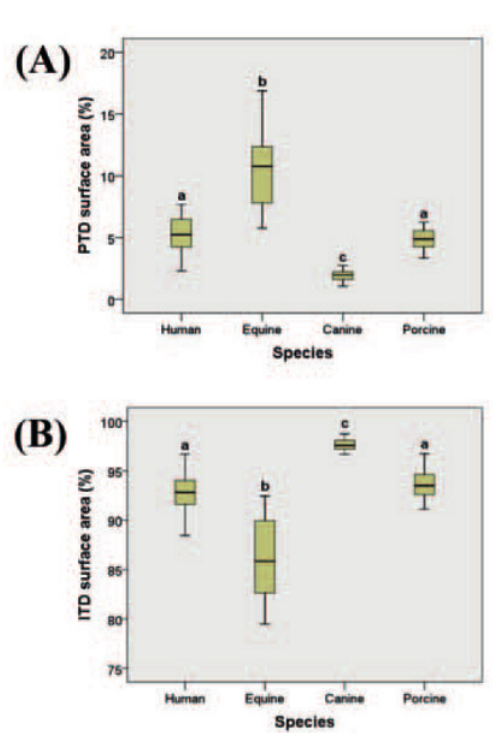
Figure 4. Box plots show median, upper and lower quartiles and the range of results of (A) PTD surface area and (B) ITD surface area of human, equine, canine and porcine dentin samples. Boxes marked with the different letters are signifi cantly different